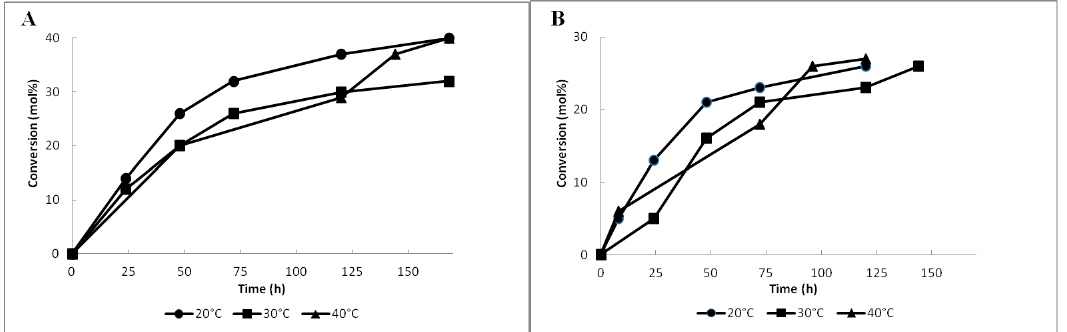
Figure 1. Effect of temperature on the conversion of acetate 4a ( A ) and propionate 4b ( B ) during Lecitase ® Ultra-catalyzed hydrolysis.